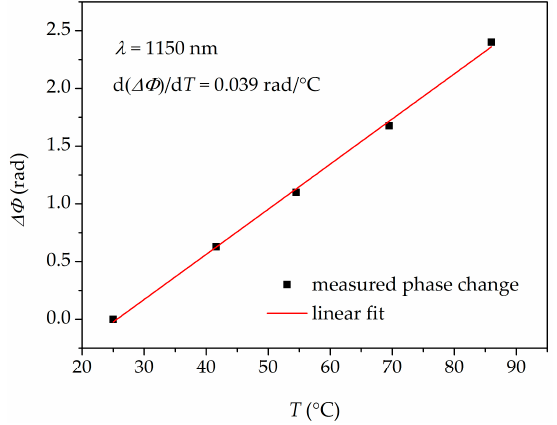
Figure 8. Differential phase shift increase Δ Φ of the interferometer induced by temperature ( T ) change at λ = 1150 nm.